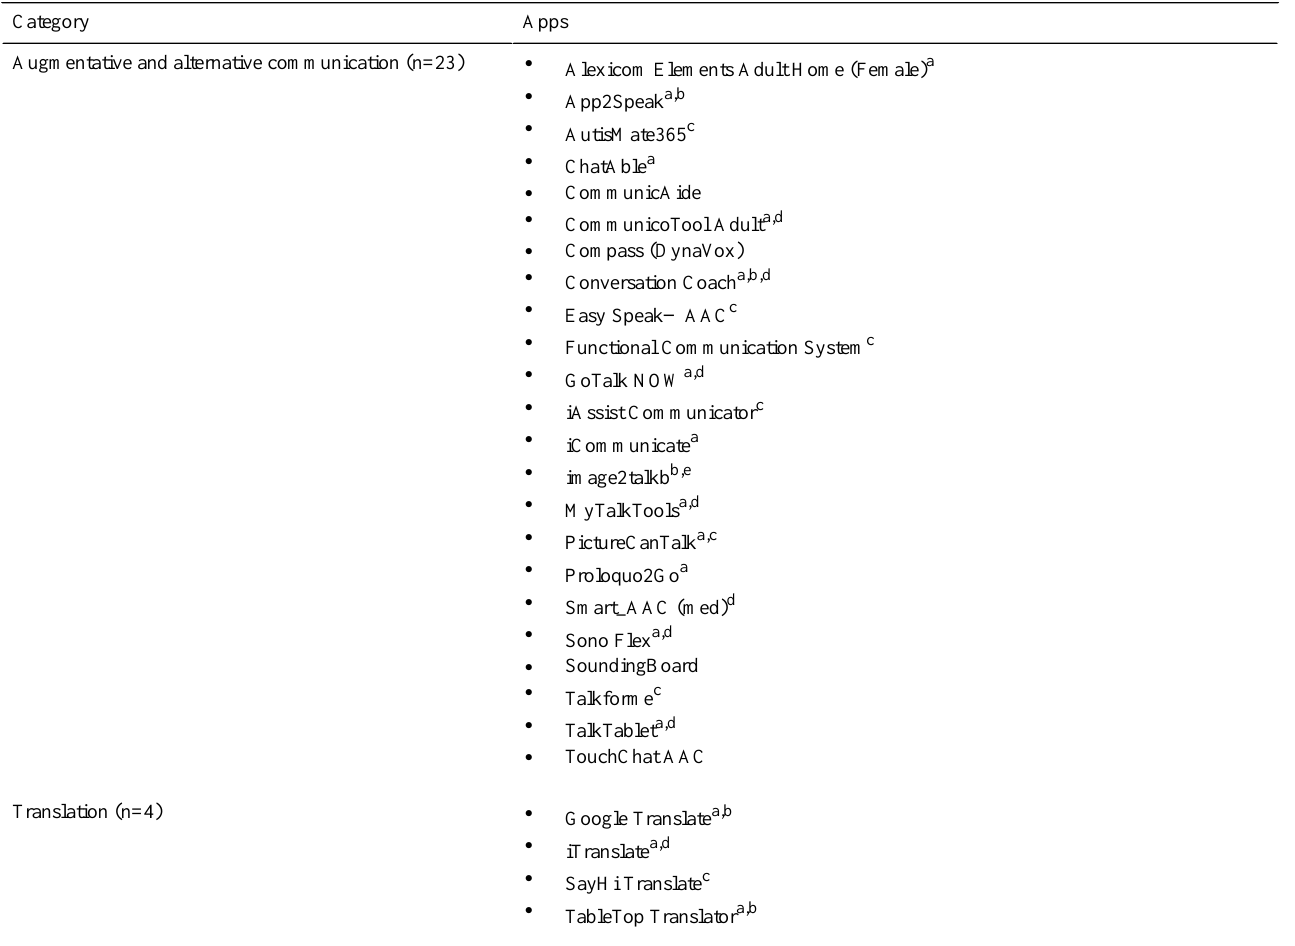
Table 3. List of communication apps evaluated in the 2015